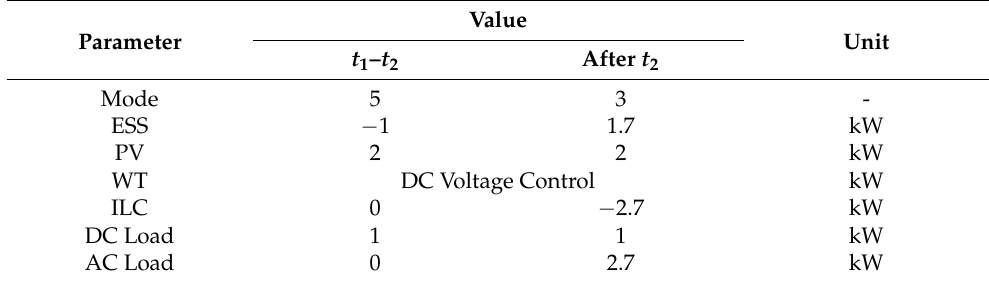
Table 8. Microgrid power flow